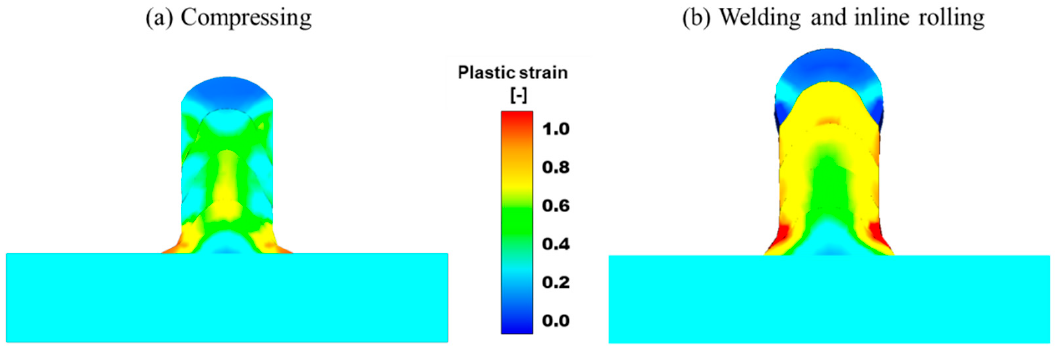
Figure 7. Simulated plastic strain induced by deformation for ( a ) compressing and ( b ) welding with inline rolling for demonstration of obtaining a suitable minimum of plastic strain.